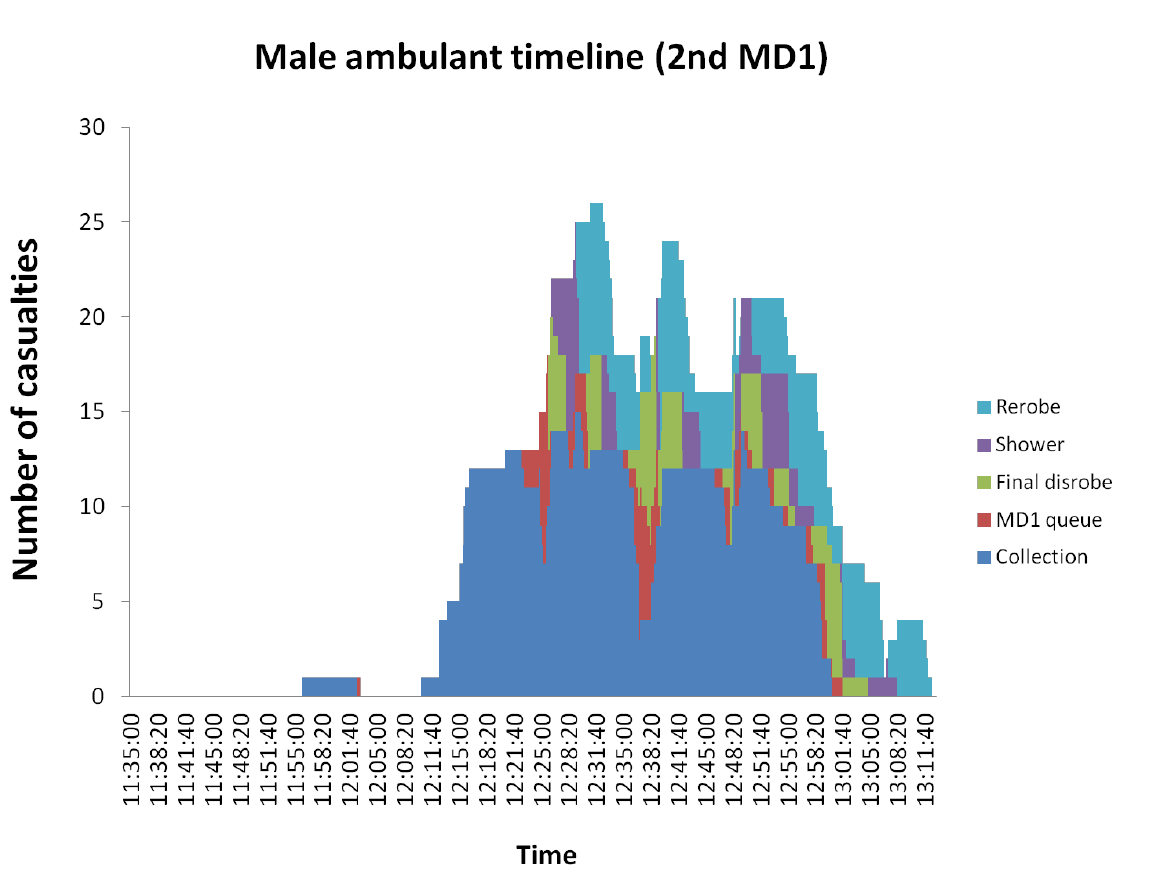
Figure A12. In contrast to the female ambulant timeline in Figure A11, 47 male ambulant casualties passed through as described in the caption of Figure A9. 13 different groups entered the MD1 giving an average group size of 3.6 (range = {1,8}). 14 casualties (32% as 3 casualties were untracked) spent less than 30 seconds in the shower. At times there were 8 casualties in the final disrobe, shower and re-robe sections, 3 more than the intended capacity of 5 casualties per